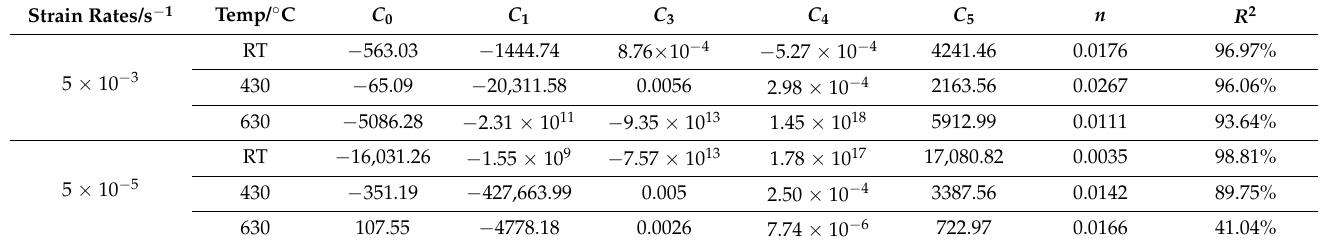
Table 6. Fitted values of the ZA model under different temperatures at the strain rates of 5 × 10 − 3 s − 1 and 5 × 10 − 5 s − 1